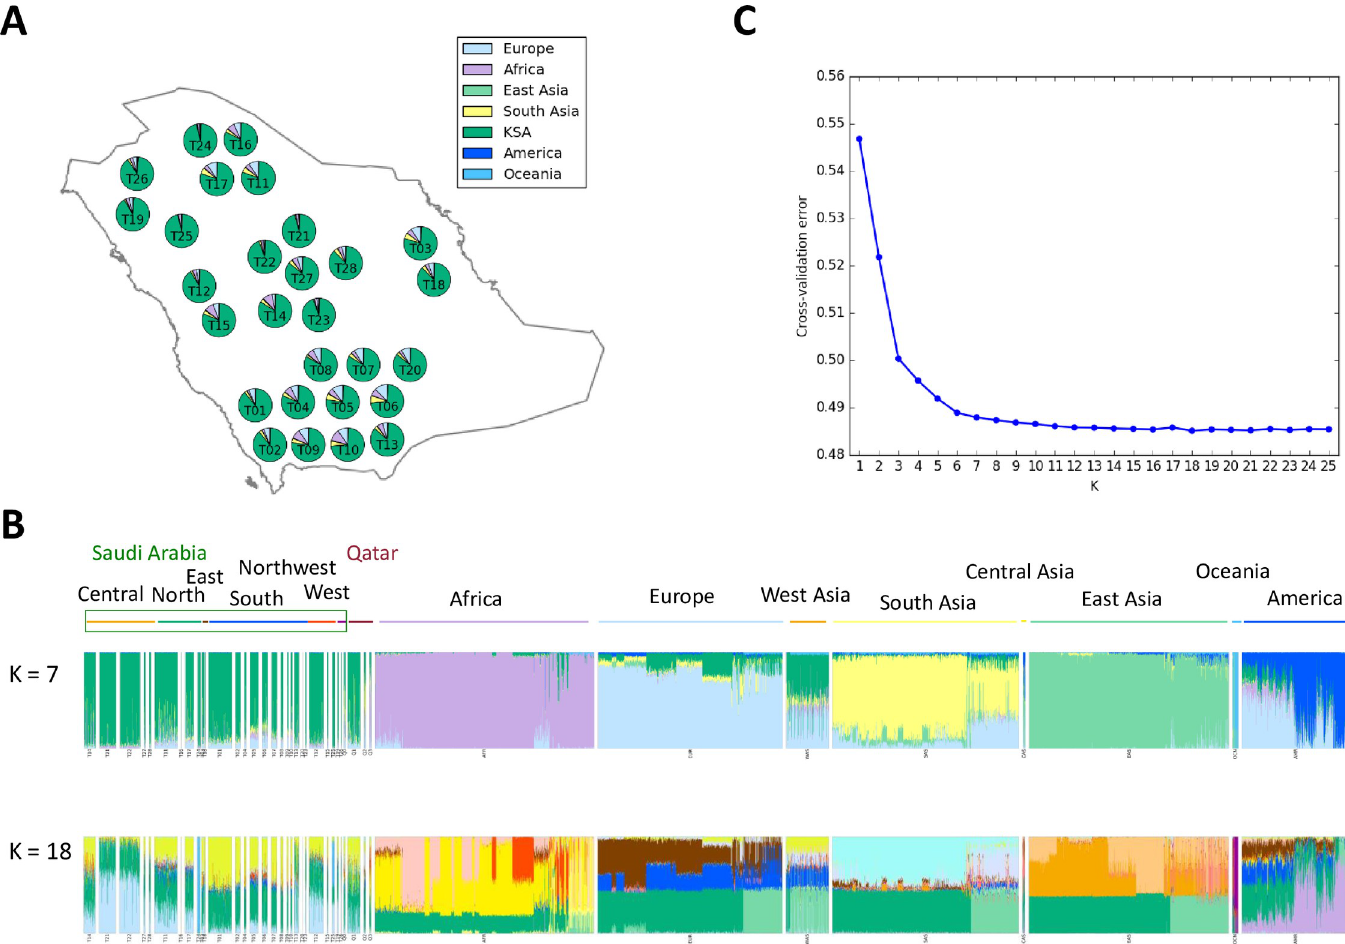
Fig 1. Saudi population structure. (A) Map of sampled tribes and admixture average proportions. Pie charts summarize per-tribe average proportions of Indigenous Arab samples at K = 7. Assumed ancestries are Arab, European, African, East Asian, South Asian, American and Oceanian. The map was made with Natural Earth (public domain). (B) Global ancestry proportions at K = 7 (top) and K = 18 (bottom) estimated with ADMIXTURE including African, European, Asian, American, Oceanian and Arab. (C) Cross-validation error for K runs from 1 to 25, K = 18 has the lowest cross-validation